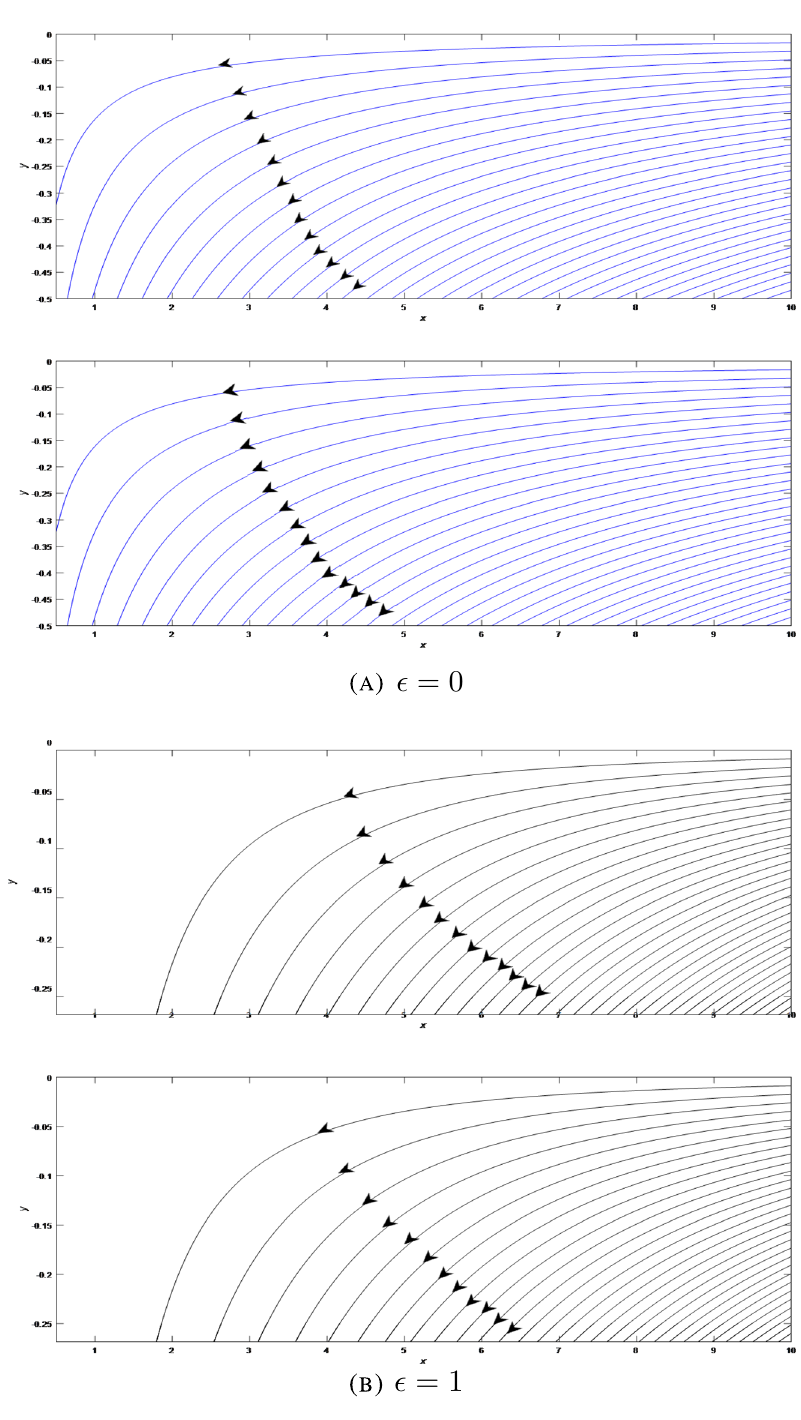
1 and t 5 for two-dimensional and = =